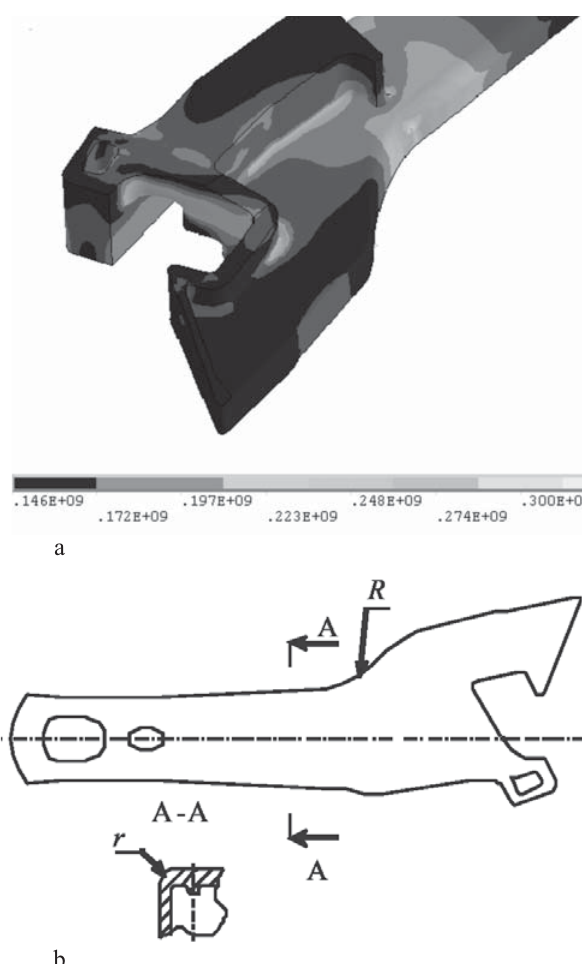
Fig. 3. Stress distributions in the body of the automatic coupler when axial force T= 3150 kN is applied (a) the rounded radii modifi ed during calculations